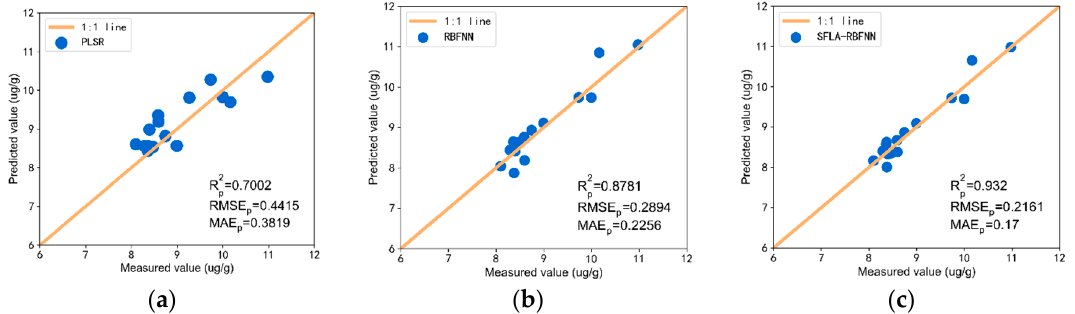
Figure 8. sCARS-SPA estimated results in Daye: ( a ) PLSR estimated results; ( b ) RBFNN estimated results; ( c ) SFLA-RBFNN estimated results.